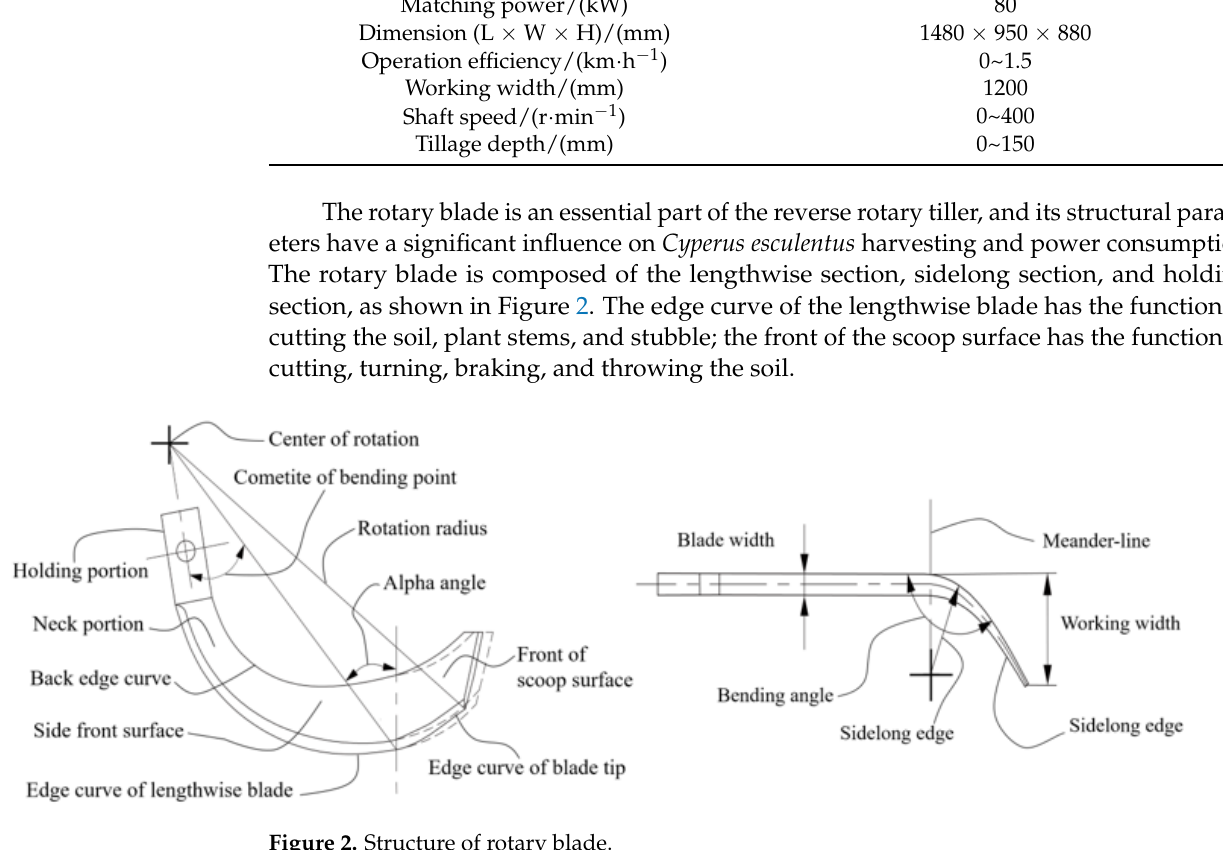
Table 1. Main parameters of reverse rotary tiller.